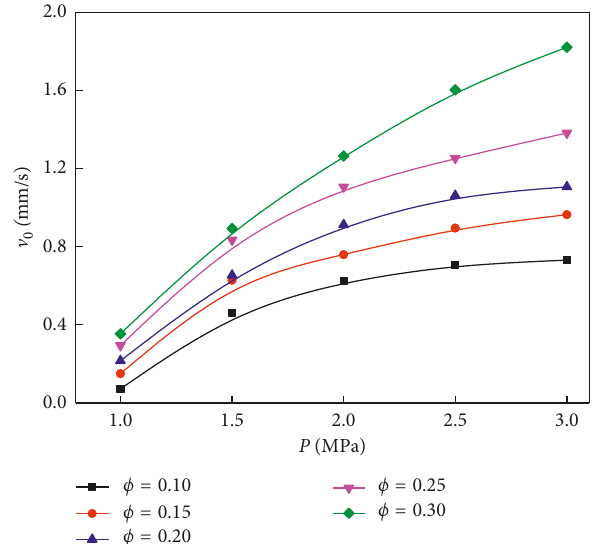
Figure 4: Seepage velocity variation curve of fractured sandstones. Figure